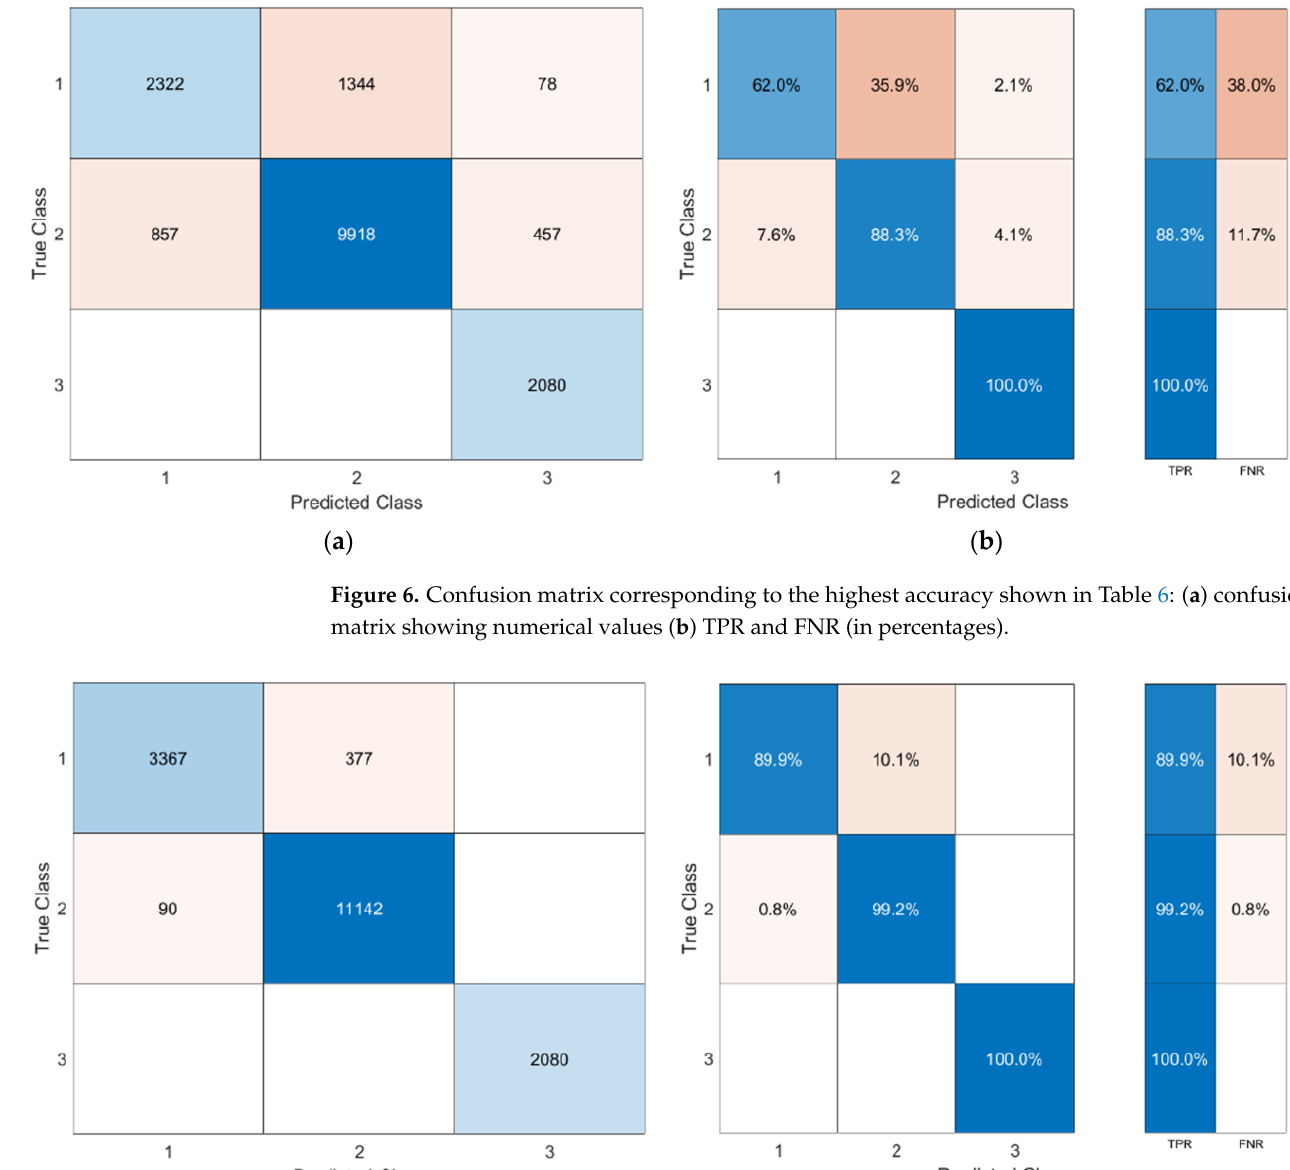
Figure 5. Confusion matrix corresponding to the highest accuracy as shown in Table 5: ( a ) confu- sion matrix showing numerical values ( b ) TPR and FNR (in percentages).